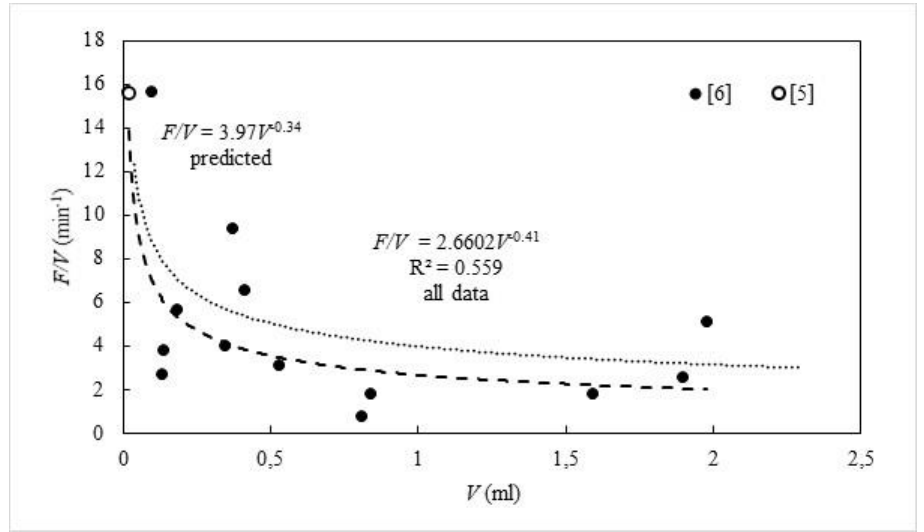
Figure 2. Halichondria panicea . Volume-specific filtration rate ( F/V ) as a function of body volume ( V ) of single-osculum explants. The model-predicted curve (dotted) based on [5] (open symbol) is shown along with the power-function regression line for all data (dashed, solid symbols) for data obtained from [6] (LM, t 0.2969, 12 = − 2.859, p = 0.0013).